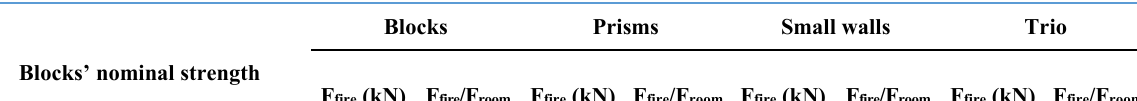
Table 3. Residual compression strength after 70 minutes under the ISO 834 Standard